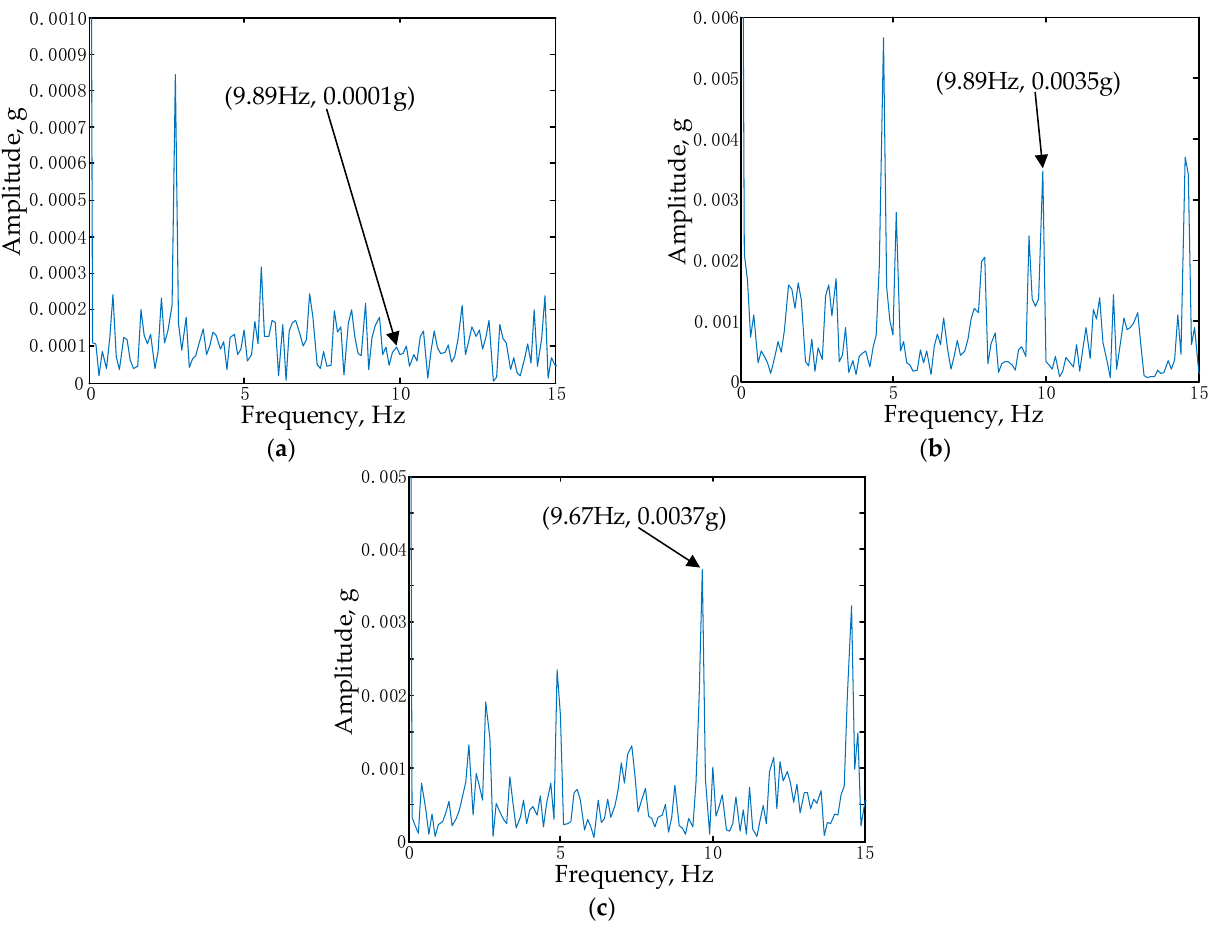
Figure 5. Resonant demodulated spectra of the vibration acceleration signal of the Y100L2-4 motor with a full load: ( a ) healthy; ( b ) slight cage fault; ( c ) severe cage fault. Table 9. Bearing cage fault diagnosis results of the Y100L2-4 motor with a full load.